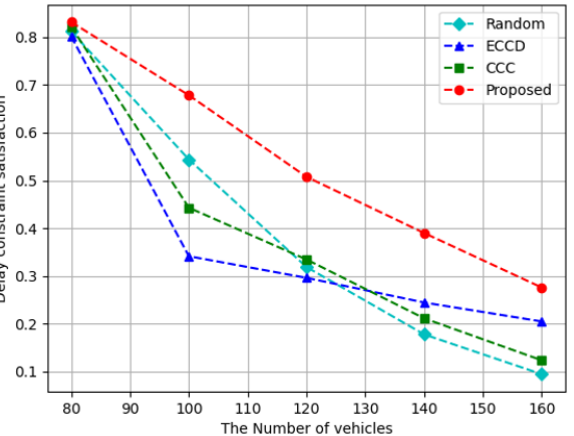
Figure 5. Delay constraint satisfaction with respect to the increase in the number of vehicles.